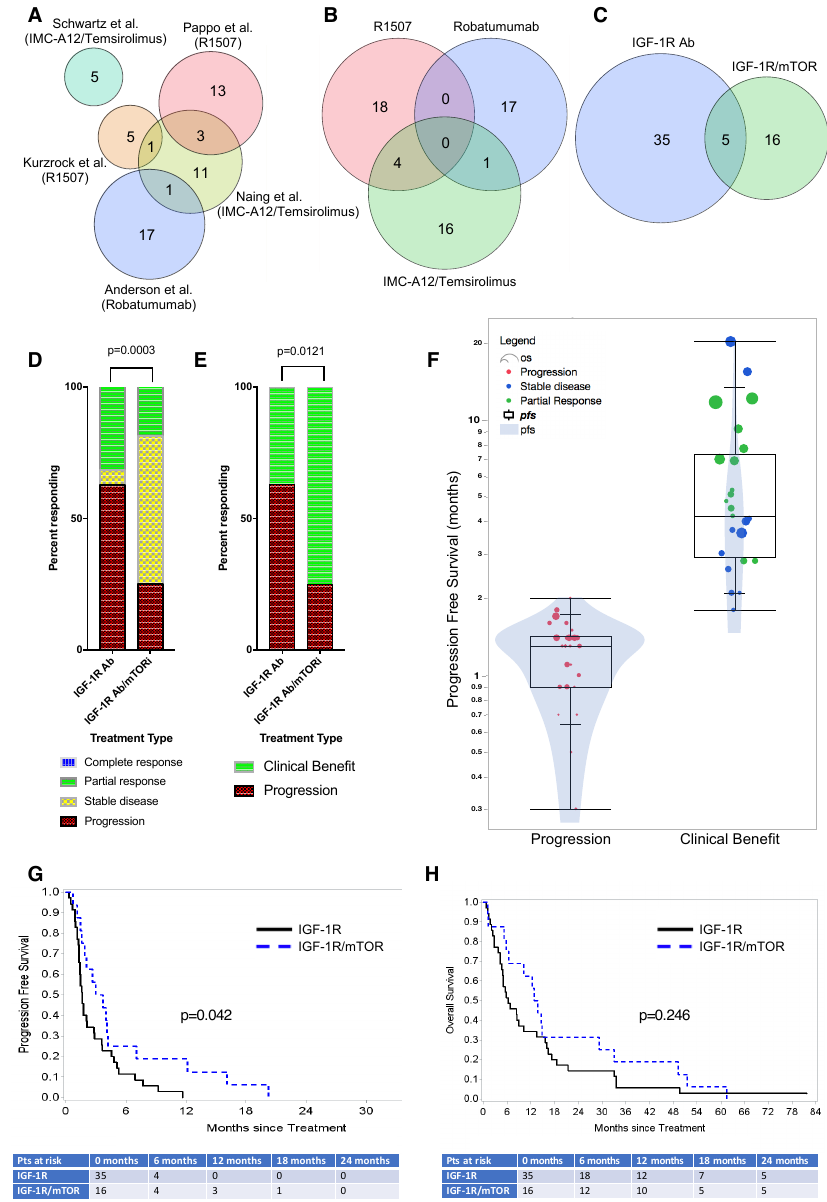
Figure 1. ( A ) Meta-analysis of five trials indicates that combined IGF-1R / mTORi-based therapy leads to superior clinical outcomes compared to single-agent IGF-1R mAb treatment. A Venn diagram of five IGF-1R-related clinical trials conducted at MDACC. (B) The two R1507 trials have been grouped for statistical analysis. ( C ) Patients treated with either R1507 or Robatumumab IGF-1R mAbs were analyzed together. Five patients received an IGF-1R / mTOR inhibitor combination after they progressed on IGF-1R Abs and were excluded from the statistical analysis. ( D ) Best clinical response by RECIST following treatment with an IGF-1R Ab vs. IGF-1R / mTOR inhibitor combination. ( E ) Similar data categorized by clinical benefit (e.g., complete or partial response and stable disease vs. progression). ( F ) Violin plot summarizing progression-free survival for all patients. Most patients progressed after 2 cycles at 6 weeks (red), whereas PFS was significantly improved in patients that achieved a partial response (green) or stable disease (blue). Each dot represents an individual patient, and the circle diameter indicates the patient’s OS duration. The superimposed box plot indicates the interquartile range. ( G ) Kaplan–Meier curves indicate a statistically significant improvement for the IGF-1R / mTOR inhibitor combination for PFS ( p = 0.042). ( H ) The Kaplan–Meier curves of